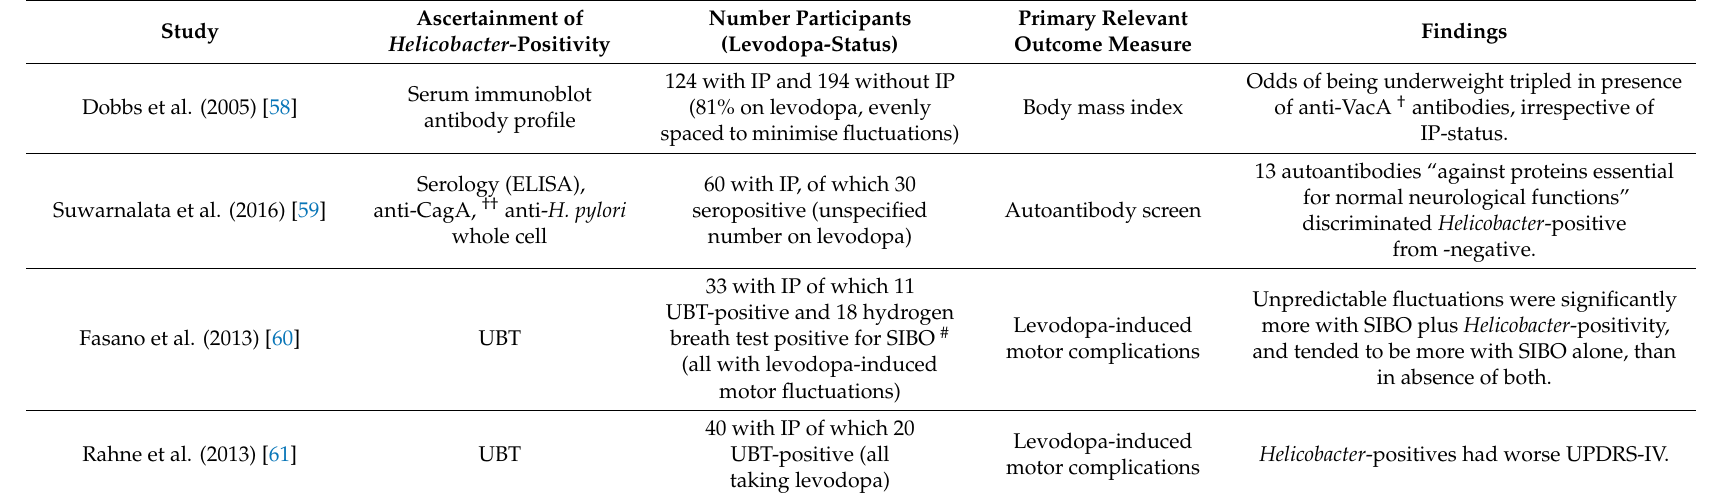
Table 4. Cross-sectional observational studies of relationship of Helicobacter -status to other outcomes in idiopathic